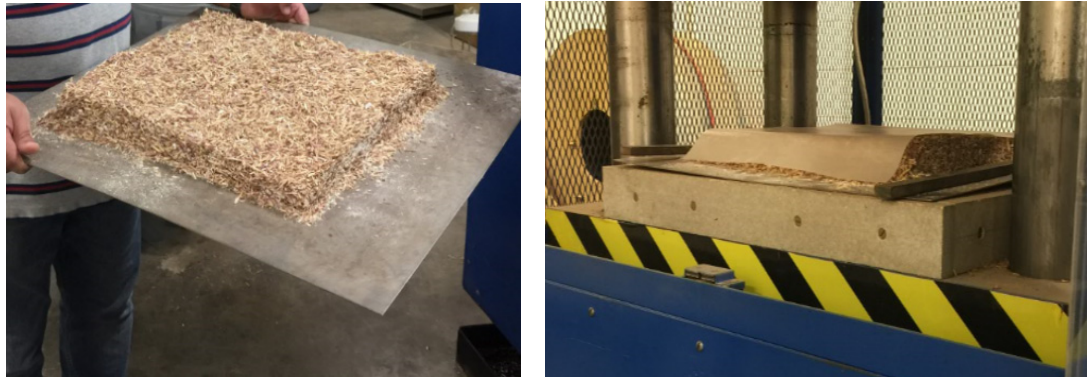
Figure 1. Manufacturing of Panel Samples.